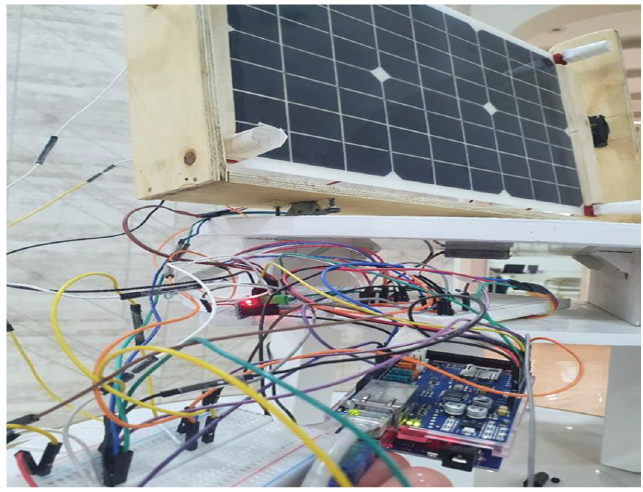
Figure 6. Hardware of photovoltaic tracking and cleaning system.